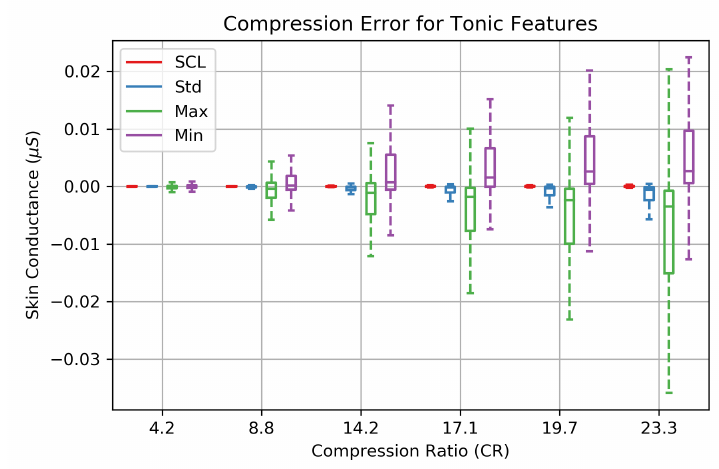
Figure 9. The absolute reconstruction errors of four EDA features computed on 253 EDA signals that were collected during in-laboratory stress tests. The SCL (EDA mean) and standard deviation are hardly effected by compression. While the low-passing filtering effect of compressing the 1D array of wavelet coefficients introduces larger error on the EDA maximum and minimum at higher compression ratios, error within the interquartile remains below 0.015 µ S for CRs up to CR = 23.3 × . Features related to phasic EDA (Sum_AUC, Sum_Amp, and Sum_Dur) are more sensitive to